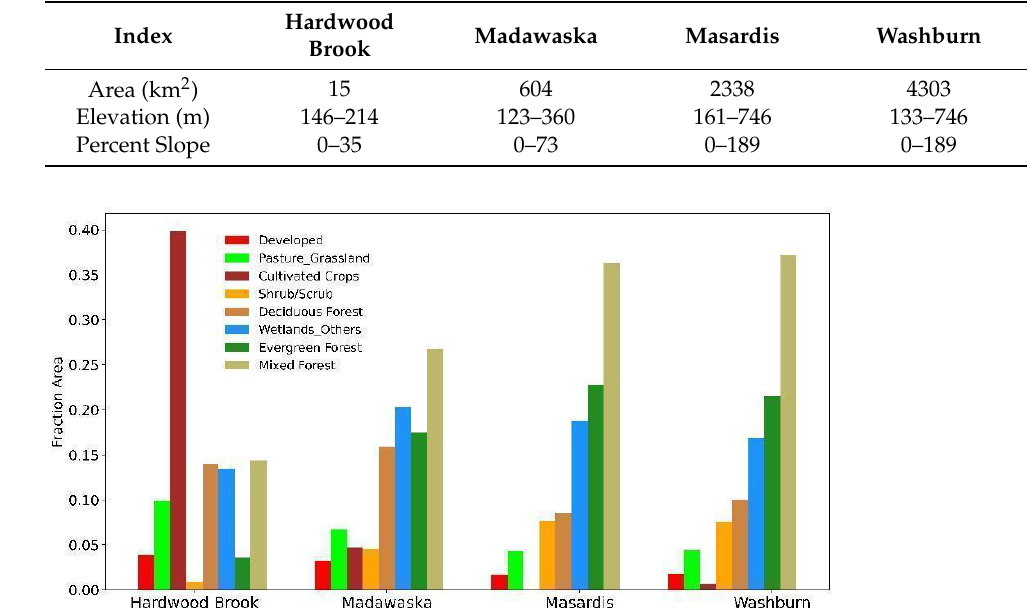
Figure 2. Major Land-cover classes for sub-basins determined by USGS NLCD.